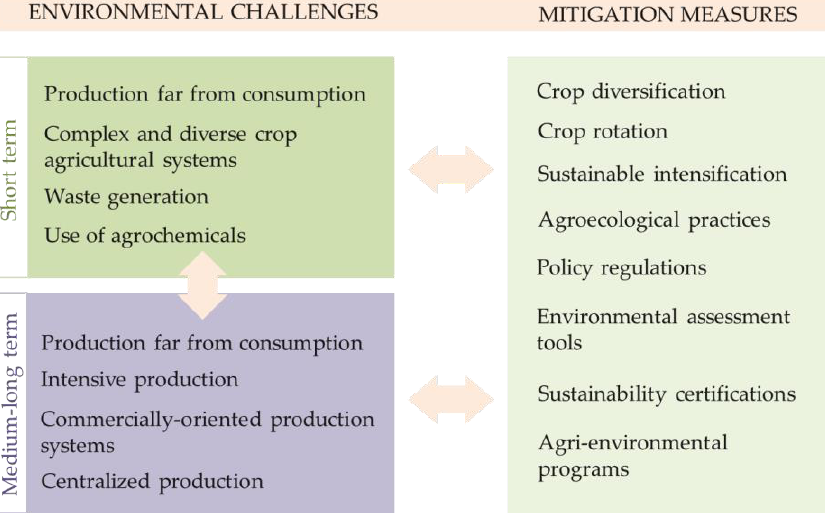
Figure 2 . Summary of the environmental challenges and potential solutions addressing the super- foods sector.